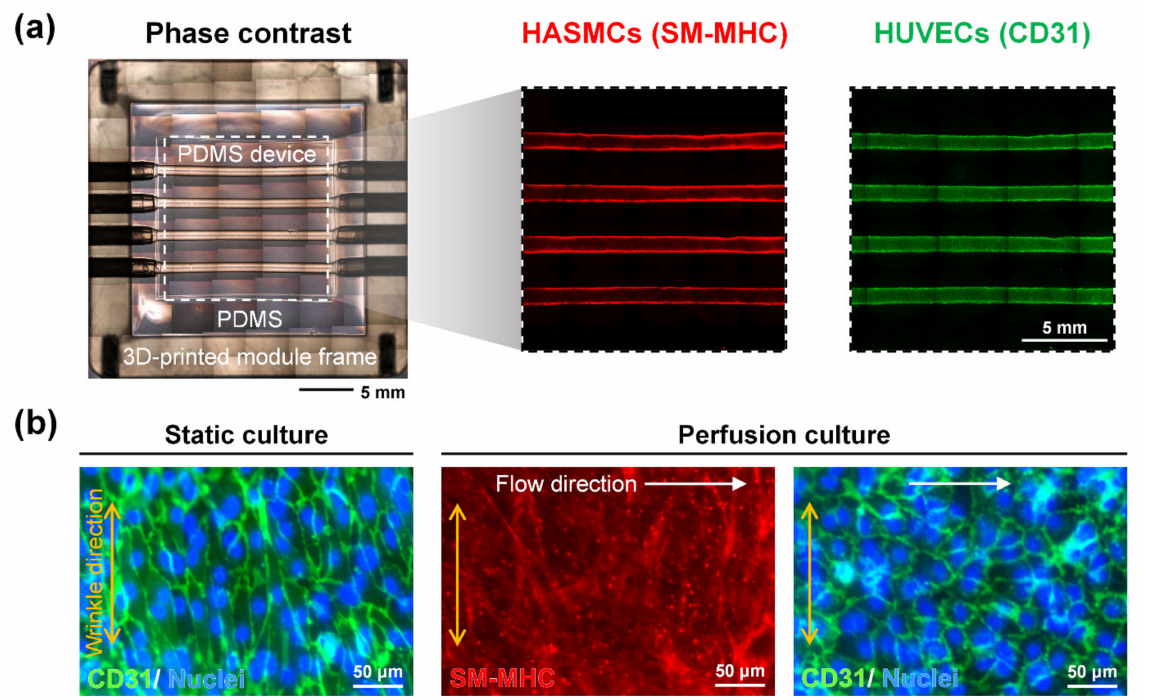
Figure 4. Cocultured HASMCs and HUVECs in an artery-mimicking multichannel device. ( a ) Phase-contrast image and immunofluorescence staining images of HASMCs and the HUVEC layer of the perfusion coculture model in a multichannel module. Several images were stitched for the whole device observation. ( b ) Smooth muscle myosin heavy chain (SM-MHC) and CD31 of the coculture model in static and perfusion culture